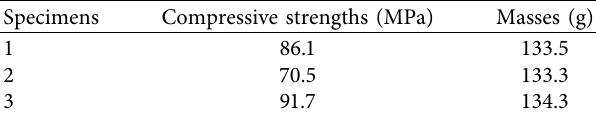
Table 4: Masses and compressive strengths for 95 percent GMS amount at 28 curing